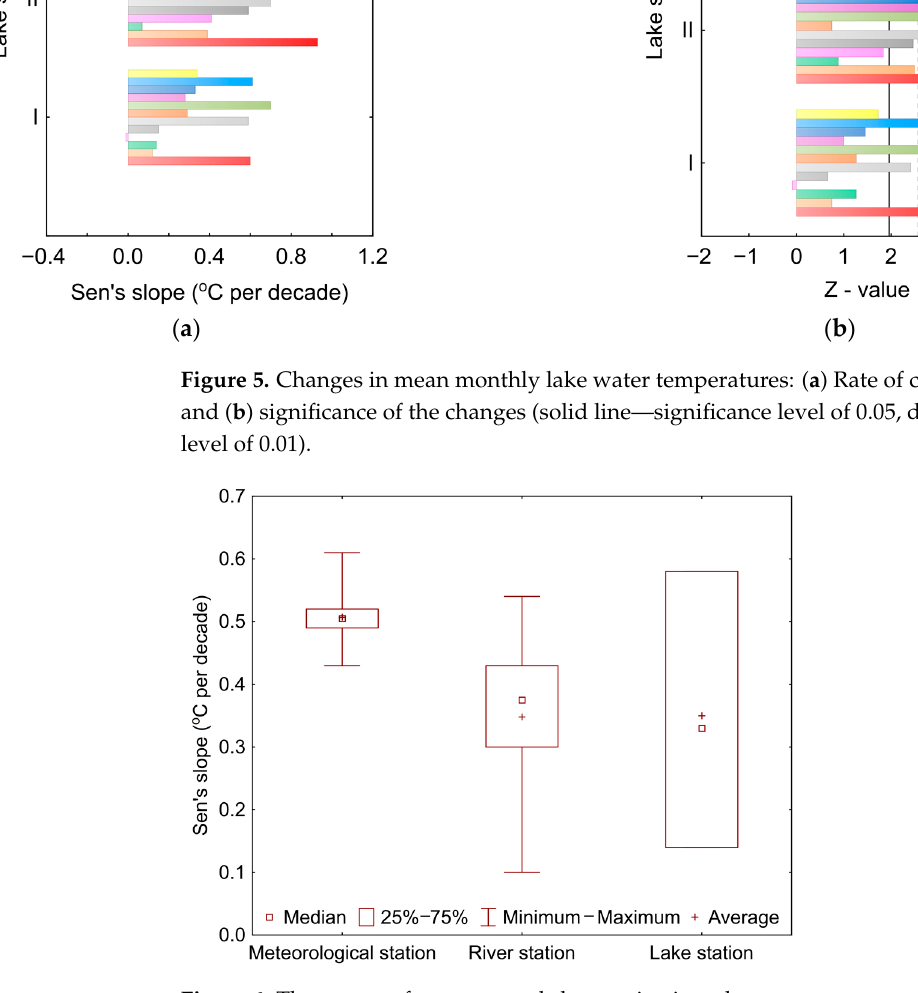
Figure 6. The ranges of mean annual changes in air and water temperatures in rivers and lakes.